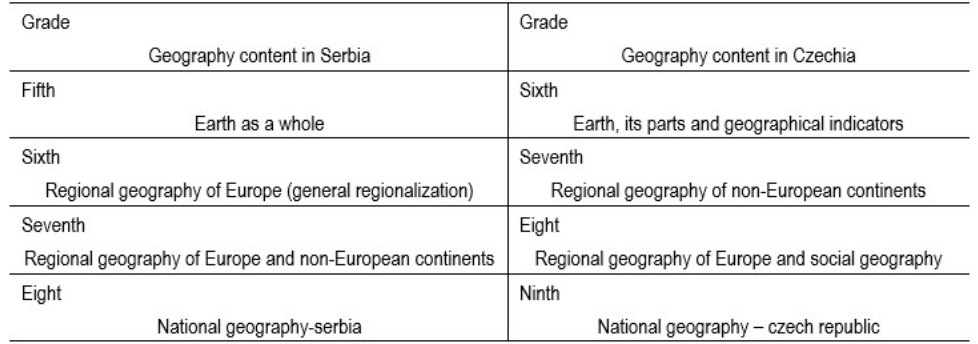
Geographical curriculum in primary schools of Serbia and